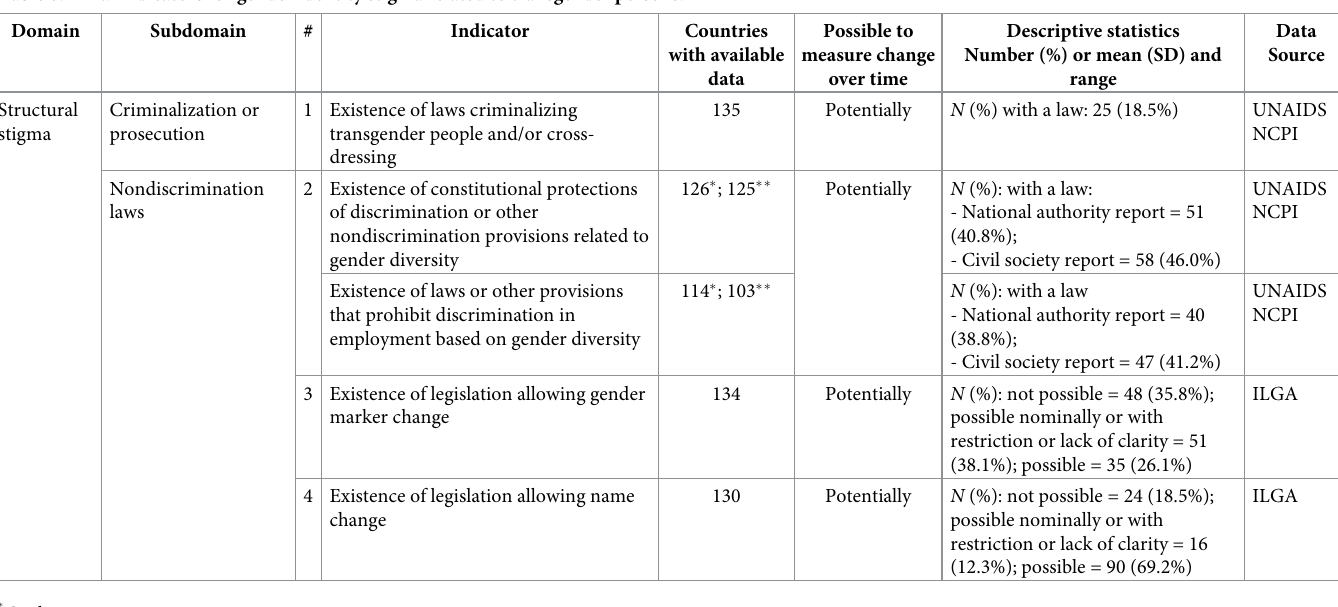
Table 6. Final indicators for gender identity stigma related to transgender